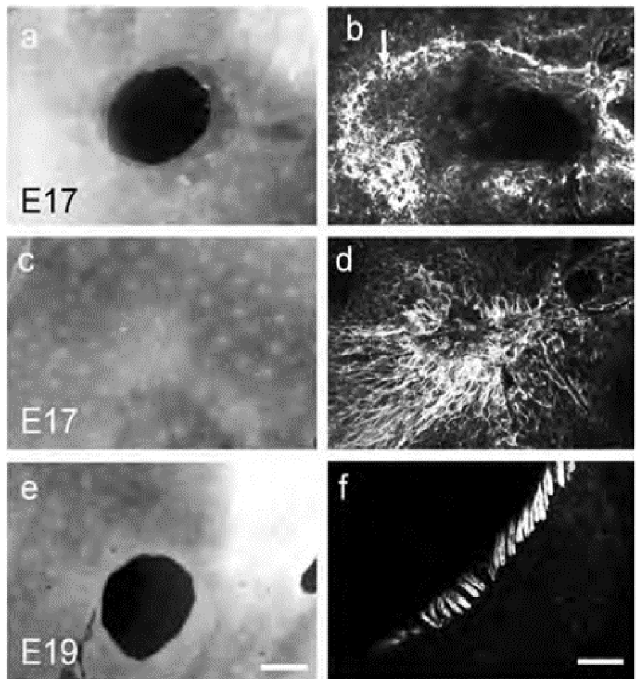
Figure 3. Actin cables are formed in early but not late gestation foetal skin. Wounds created in E17 but not E19 fetal skin, when cultured in DMEM/10%FBS re-epithelialise and close over 72 h. Wounded E17 fetal skin at ( a ) 3 h postwounding and ( c ) 72 h post-wounding. ( e ) wounded E19 fetal skin 72 h post-wounding. Phalloidin-FITC staining of F-actin reveals actin ring around E17 wound 48 ( b ) and 72 h post wounding ( d ). No cables are formed in E19 fetal skin wound ( f ). Magnification bar in ( e ) = 600 (cid:541) m and in ( f ) = 50 (cid:541) m. Arrow in ( b ) points to actin cable (Adapted from